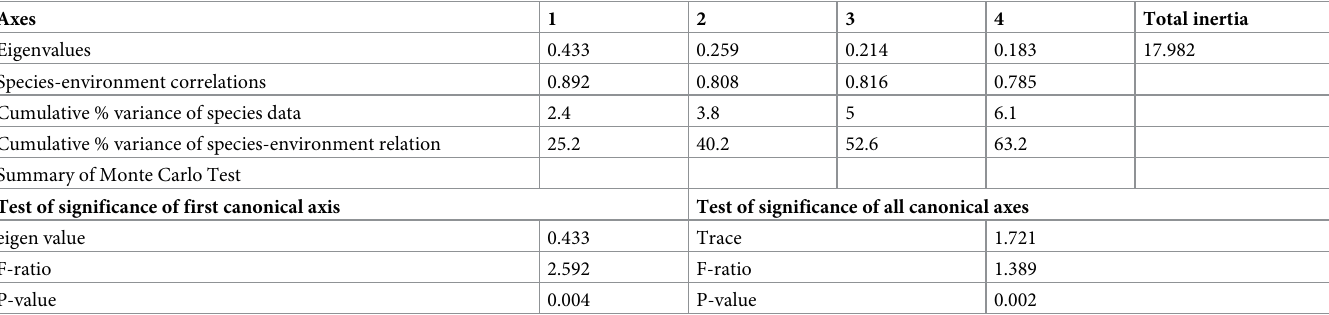
Table 1. Detailed summary CCA for all the recorded plant species and environmental